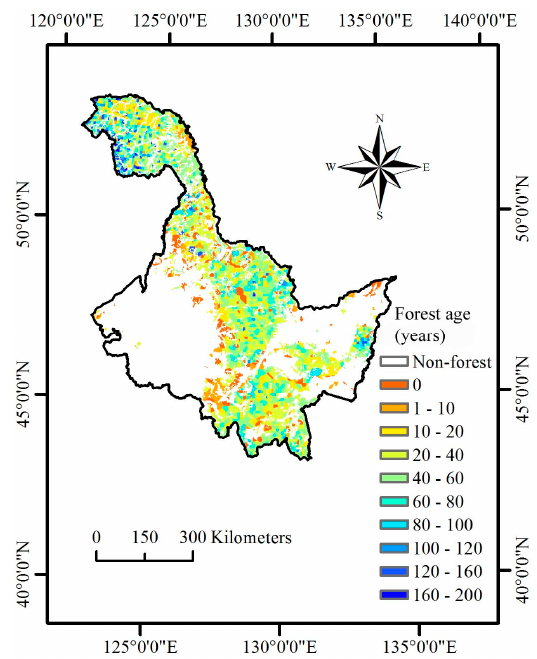
Figure 2. Spatial distribution of forest age in Heilongjiang Province, China.